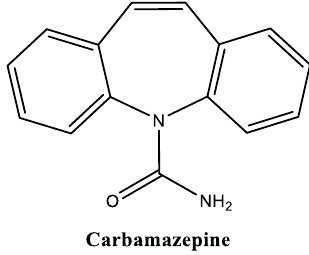
Figure 6. Structure of carbamazepine, an anticonvulsant structurally related to carbazole.